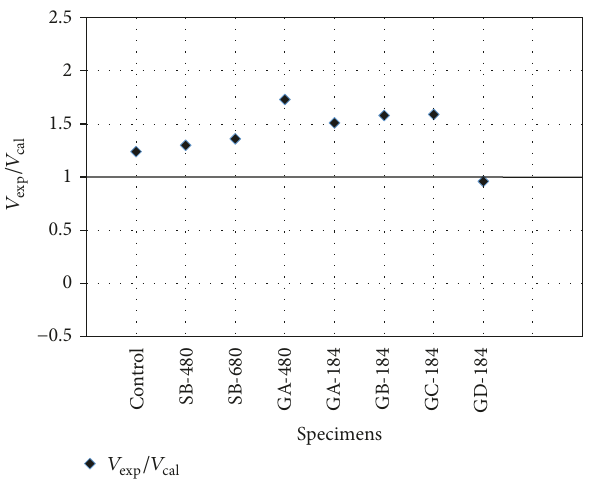
Figure 14: Comparison of experimental and calculated shear